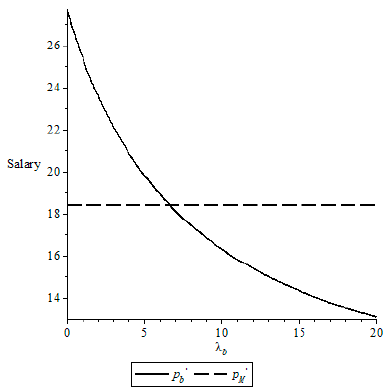
Figure 1. Change of the salary with λ b .